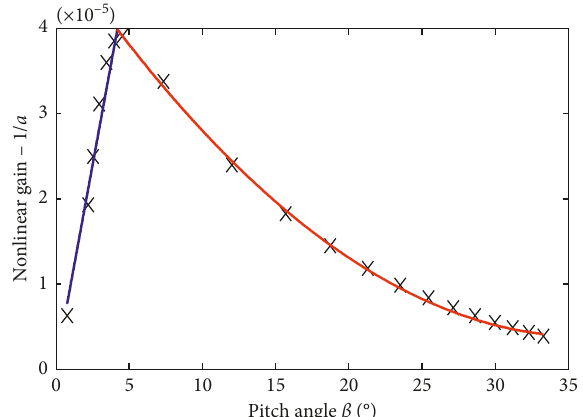
Figure 14: Fitting curve and